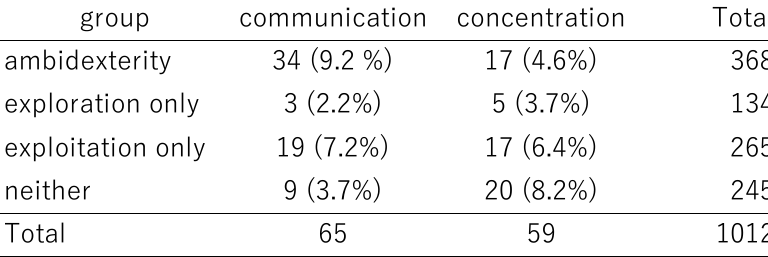
Table 3. Appearance of the words in each